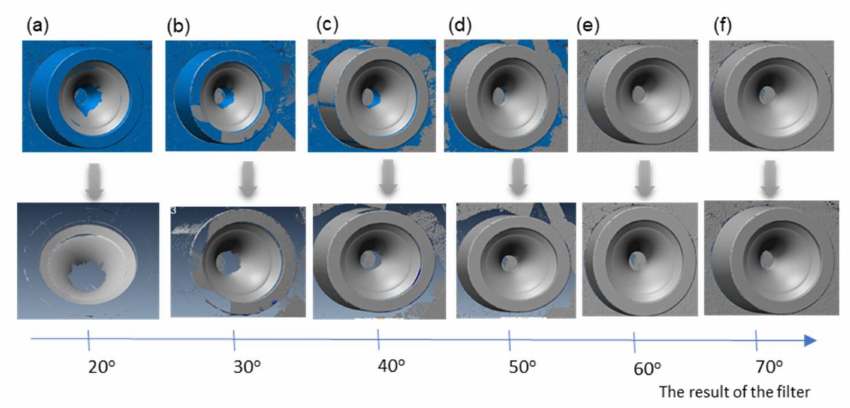
Figure 5. E ff ect of the change of the value of the angel between the normal direction and the reflected laser light in the process of filtering the measurement data on the change in the measurement area (blue-omitted area, grey-analyzed area: ( a ) up to 20 ◦ , ( b ) up to 30 ◦ , ( c ) up to 40 ◦ , ( d ) up to 50 ◦ , ( e ) up to 60 ◦ , ( f ) up to 70 ◦ for a new